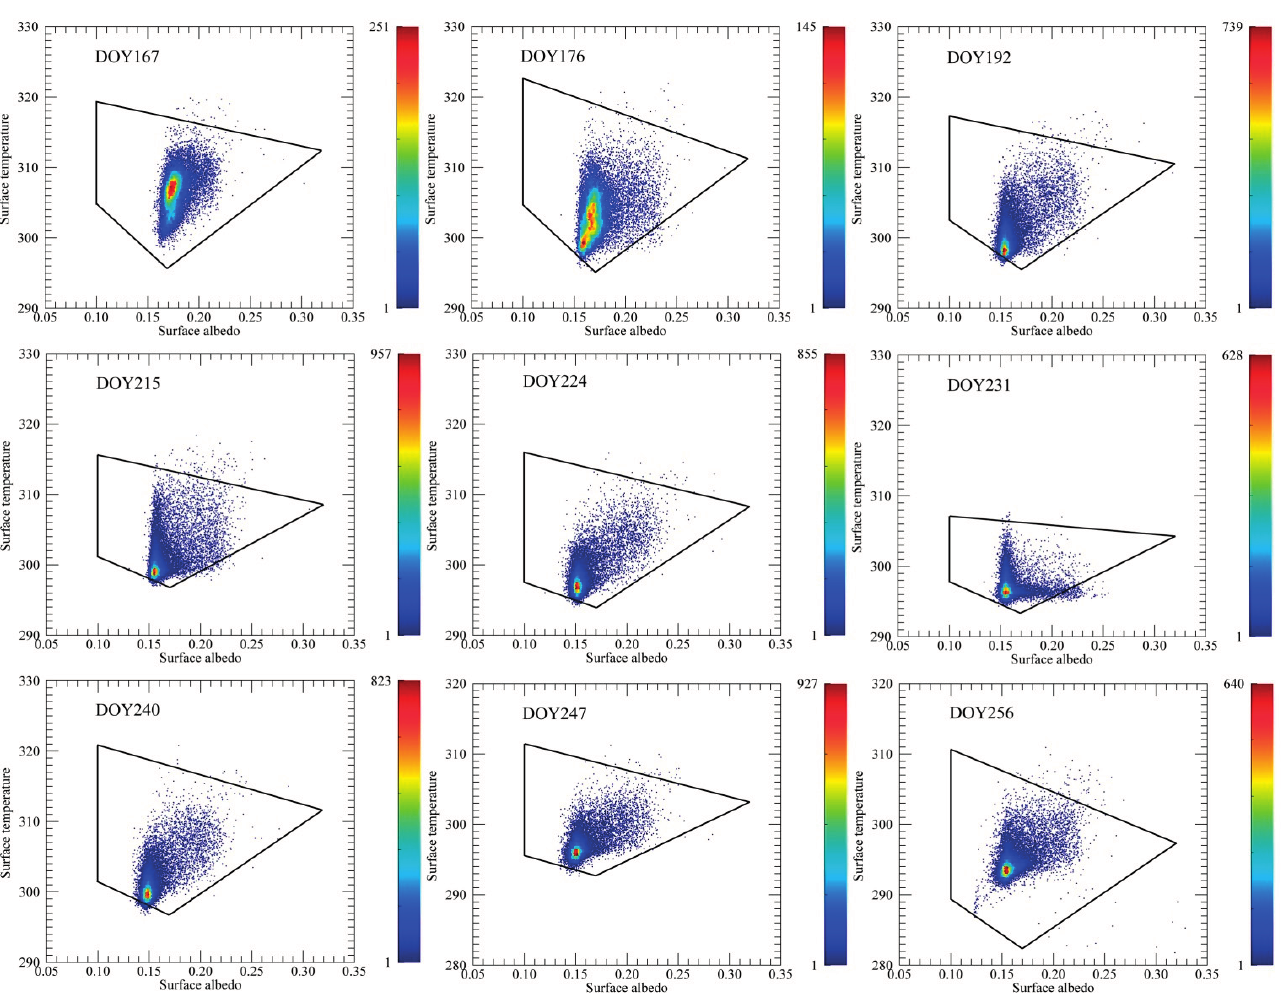
Figure 4. The spaces of surface temperature-albedo and surface temperature-green vegetation fraction, the position of dry edges, wet edges, bare soil and the full vegetation cover edge in the spaces, established by using nine senses ASTER